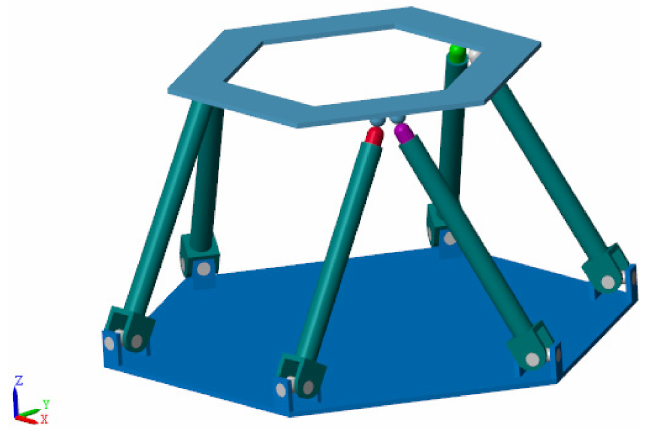
Figure 4. Multibody simulation model of the Stewart platform.